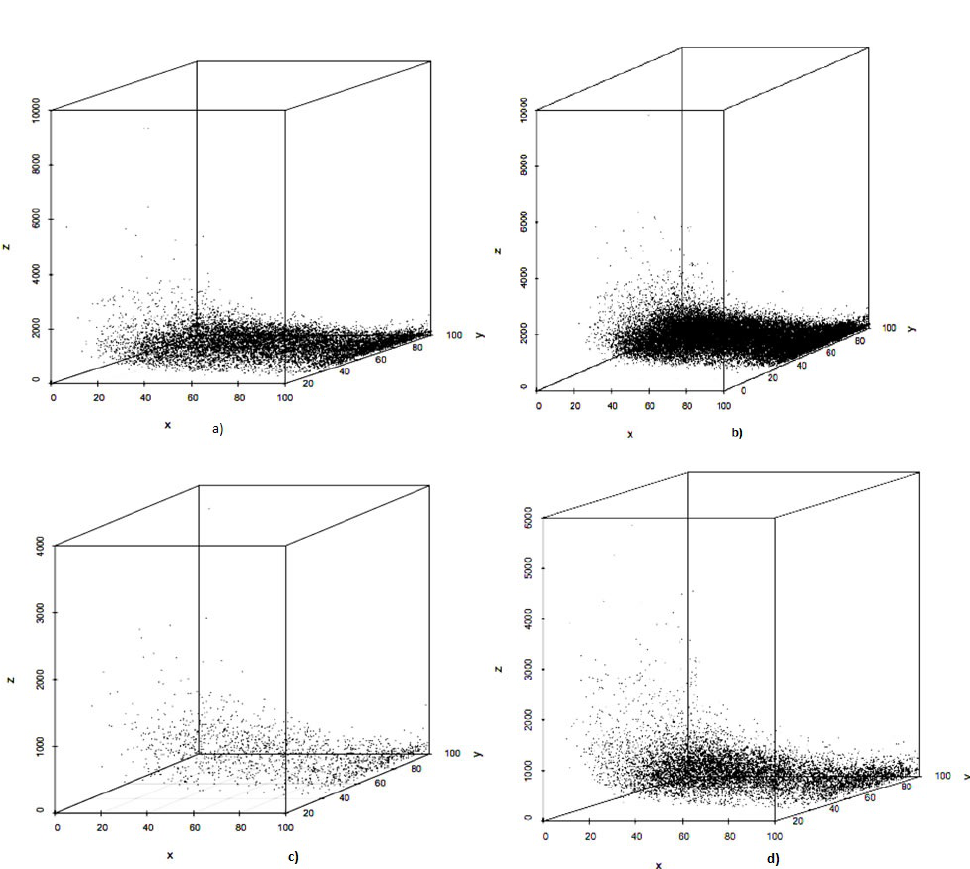
Figure 4: Distribution of transcripts according to threshold variables associated to BLAST results. (a). C. canephora; (b). C. arabica; ( c ). C. kapakata; (d). C. liberica; x-axis: percentage coverage, y-axis: percentage identity, z-axis: contig